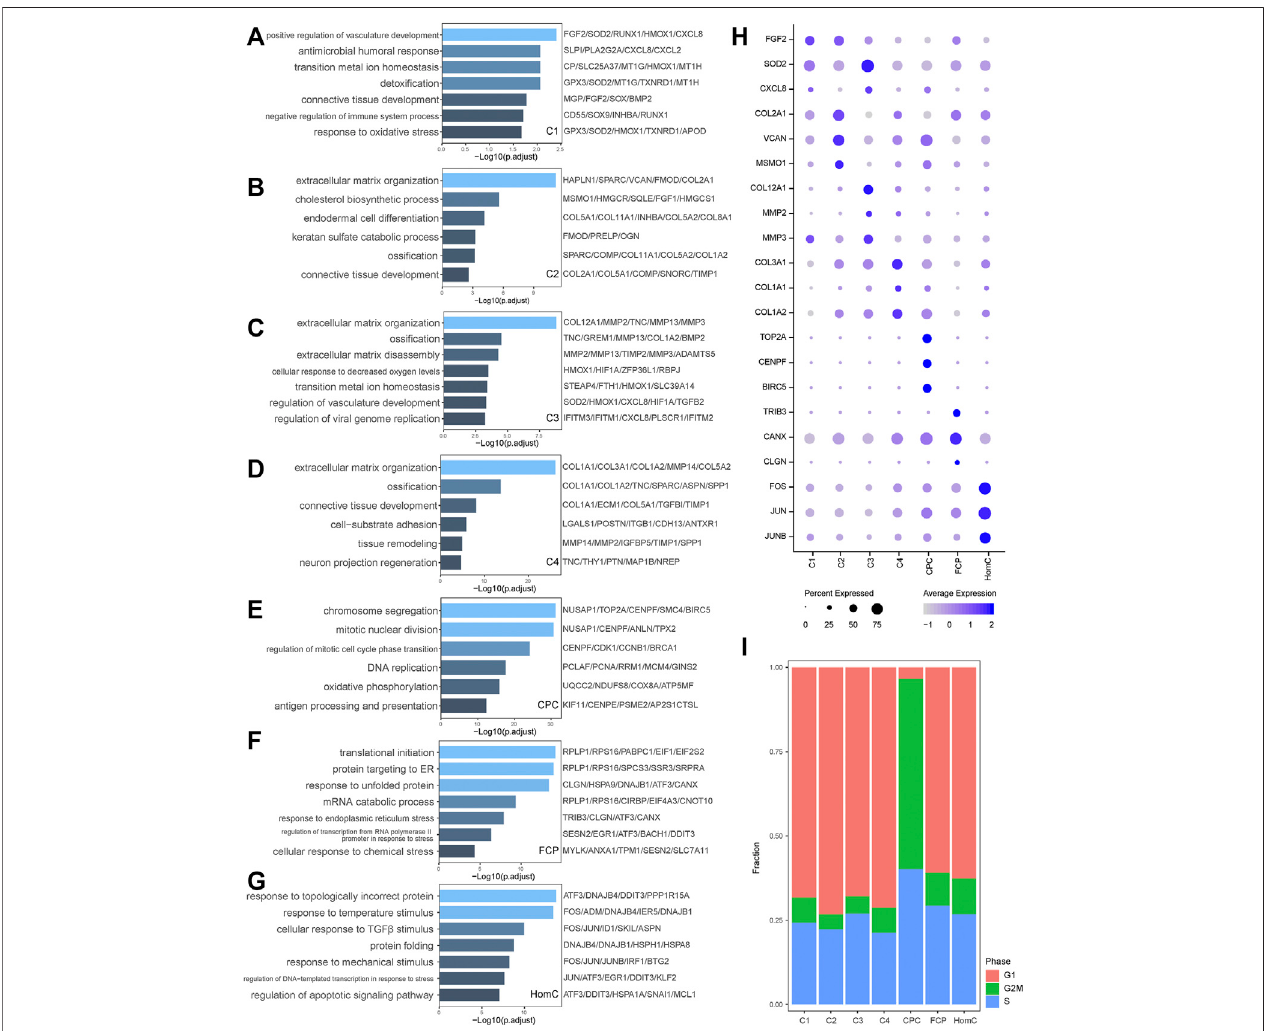
FIGURE 2 | Characterization of biological functions of chondrocyte subclusters. (A – G) Bar plots showed the upregulated pathways and representative genes corresponding to seven chondrocyte subclusters of C1, C2, C3, C4, CPC, FCP, and HomC, respectively, by GO analysis. (H) Dot plot showing the expression levels of selected representative genes among seven chondrocyte subclusters. Dot size indicates the percentage of cells expressing the particular genes, and the spectrum of color represents the mean average expression of the genes. (I) The proportion of cells annotated as the different cell cycle phases in seven chondrocytes subclusters. CPC, cartilage progenitor cells; FCP, fi brochondrocyte progenitors; HomC, homeostatic chondrocytes.